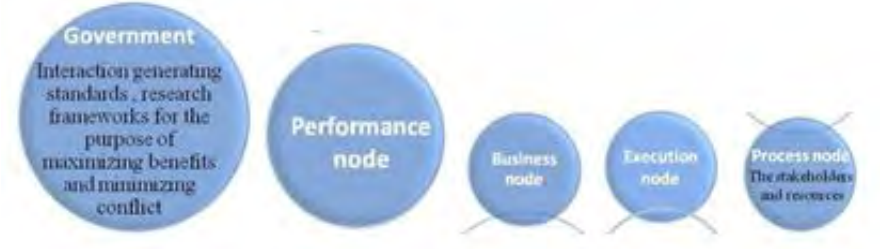
Figure 12. the three different sizes ofthe nodes that represent the